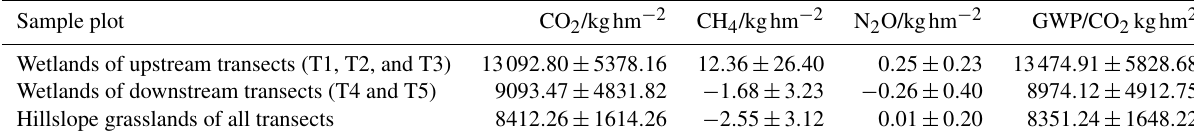
Typical grassland Table 6. Cumulative annual emission flux and global warming potential of GHGs in riparian wetlands and grasslands. Sample plot Wetlands of upstream transects (T1, T2, and